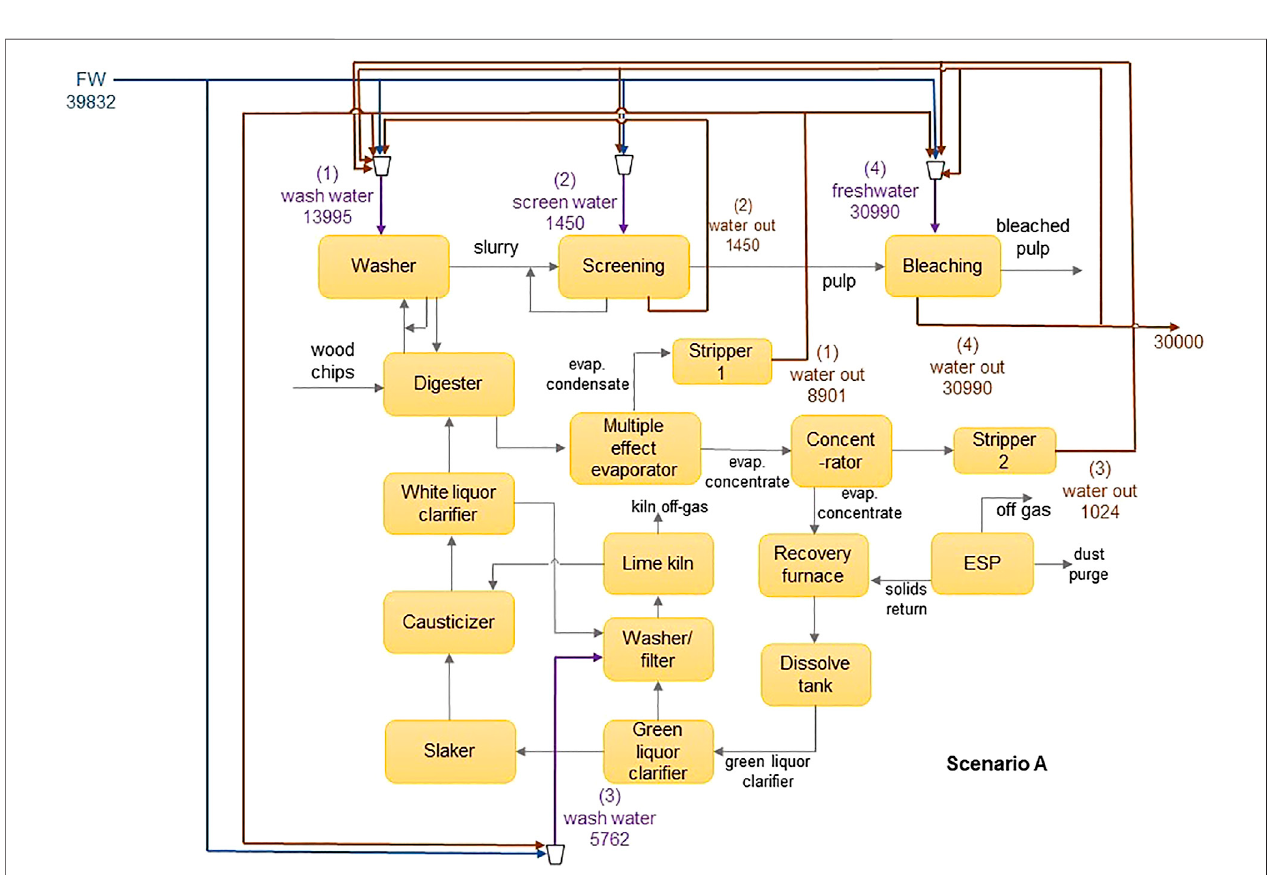
FIGURE 4 | Optimal fl owsheet for Scenario A (no